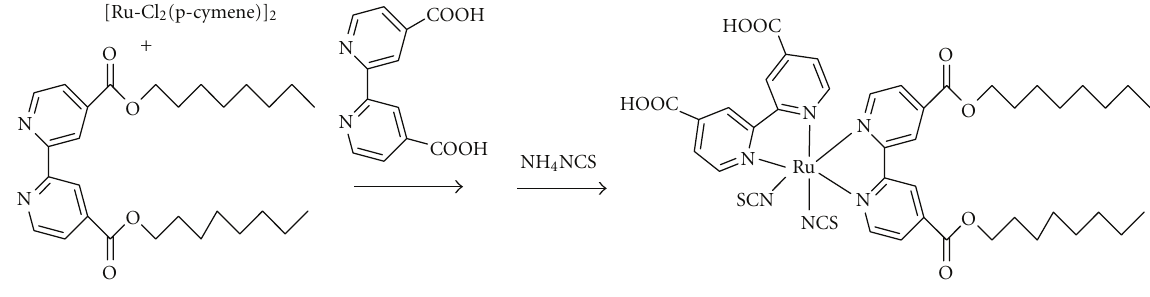
Figure 22: Synthesis route of the ruthenium dye, S8 (taken from [40]).